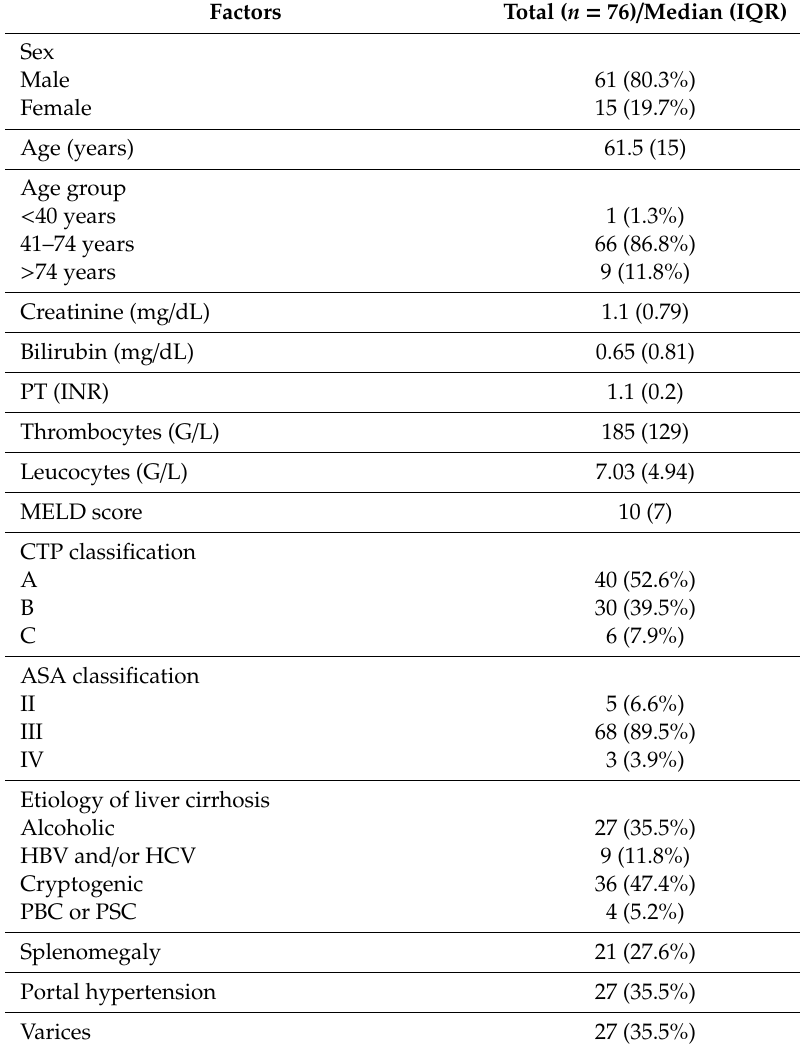
Table 1. Baseline characteristics of the study